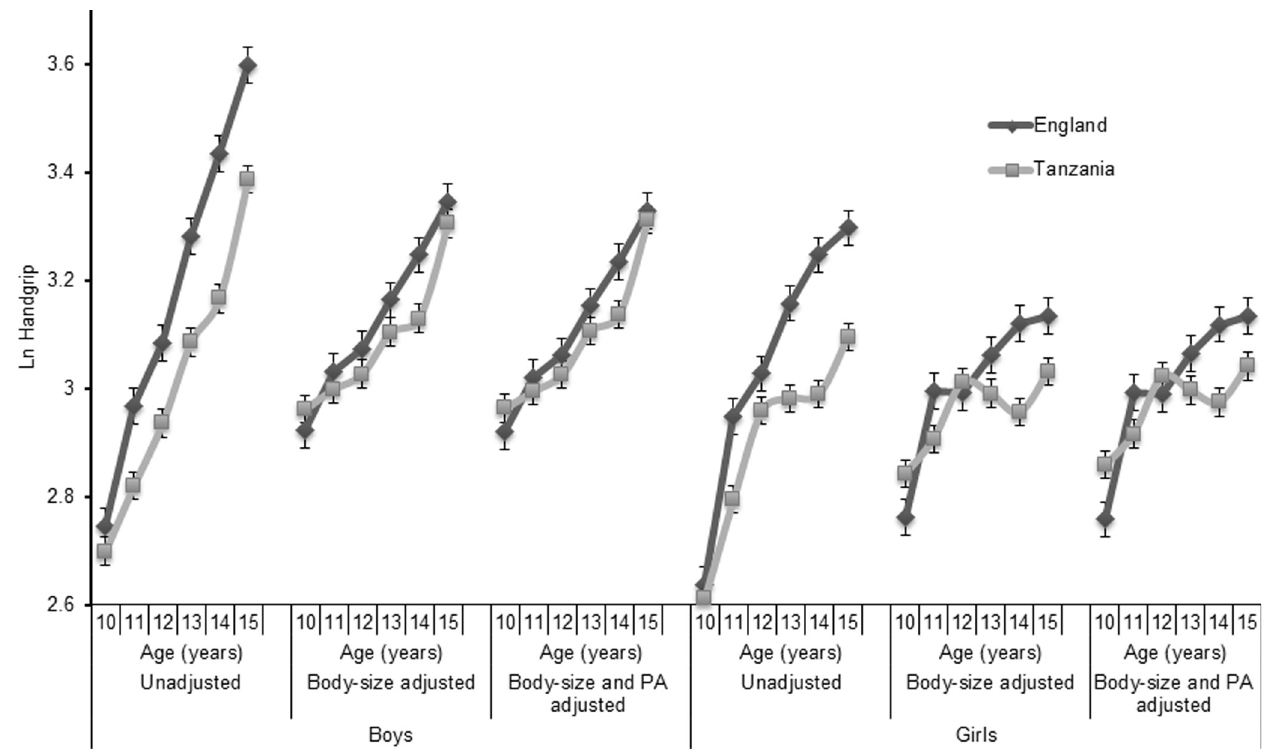
Fig 3. Handgrip strength of English and Tanzanian schoolchildren: Effects of adjusting for body size and physical activity. Body-size adjustments made using allometric scaling for Ln(Mass) and Ln(Stature). PA-Physical Activity–assessed from self-report using the Physical Activity Questionnaire for Children or